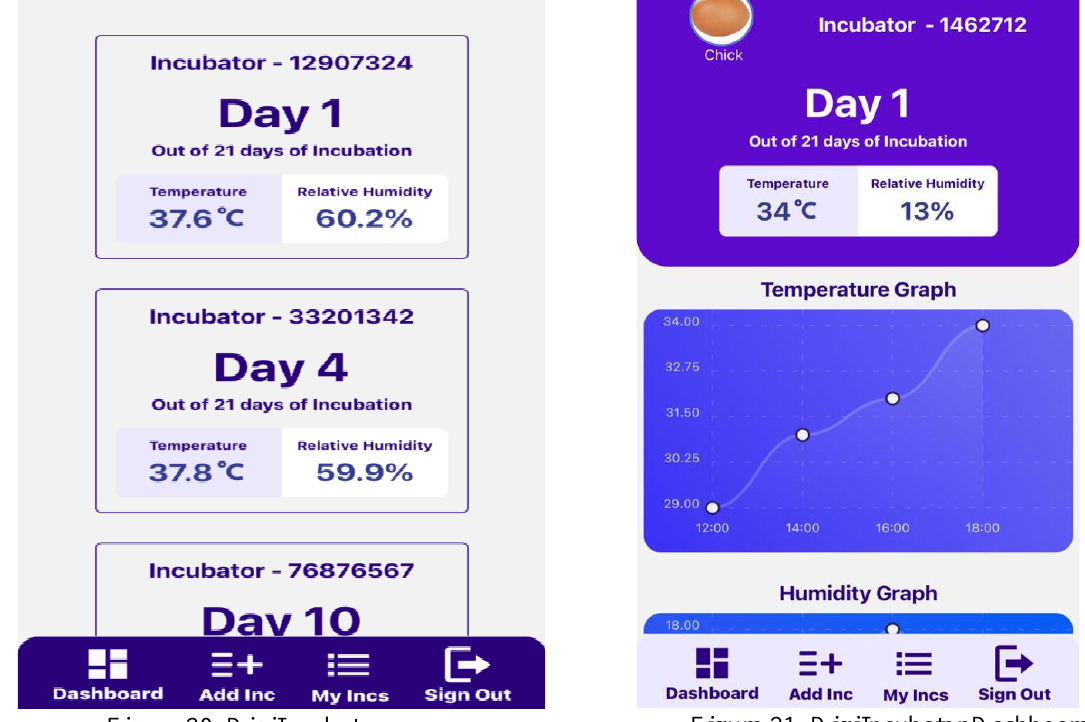
Figure 20. DigiIncubator screen Figure 21. DigiIncubator Dashboard